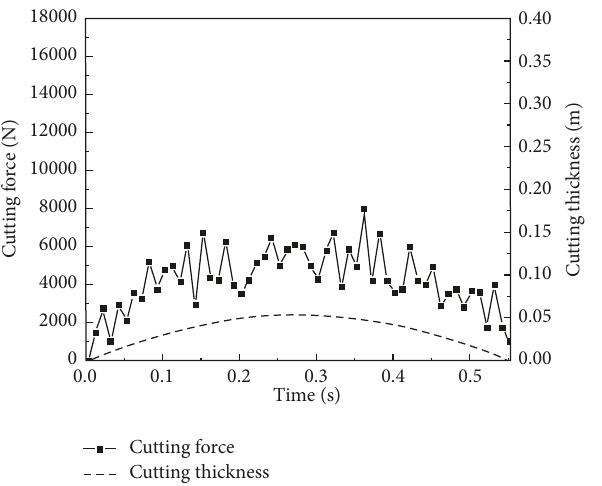
Figure 10: Cutting force of conical pick under the cutting parameter F .